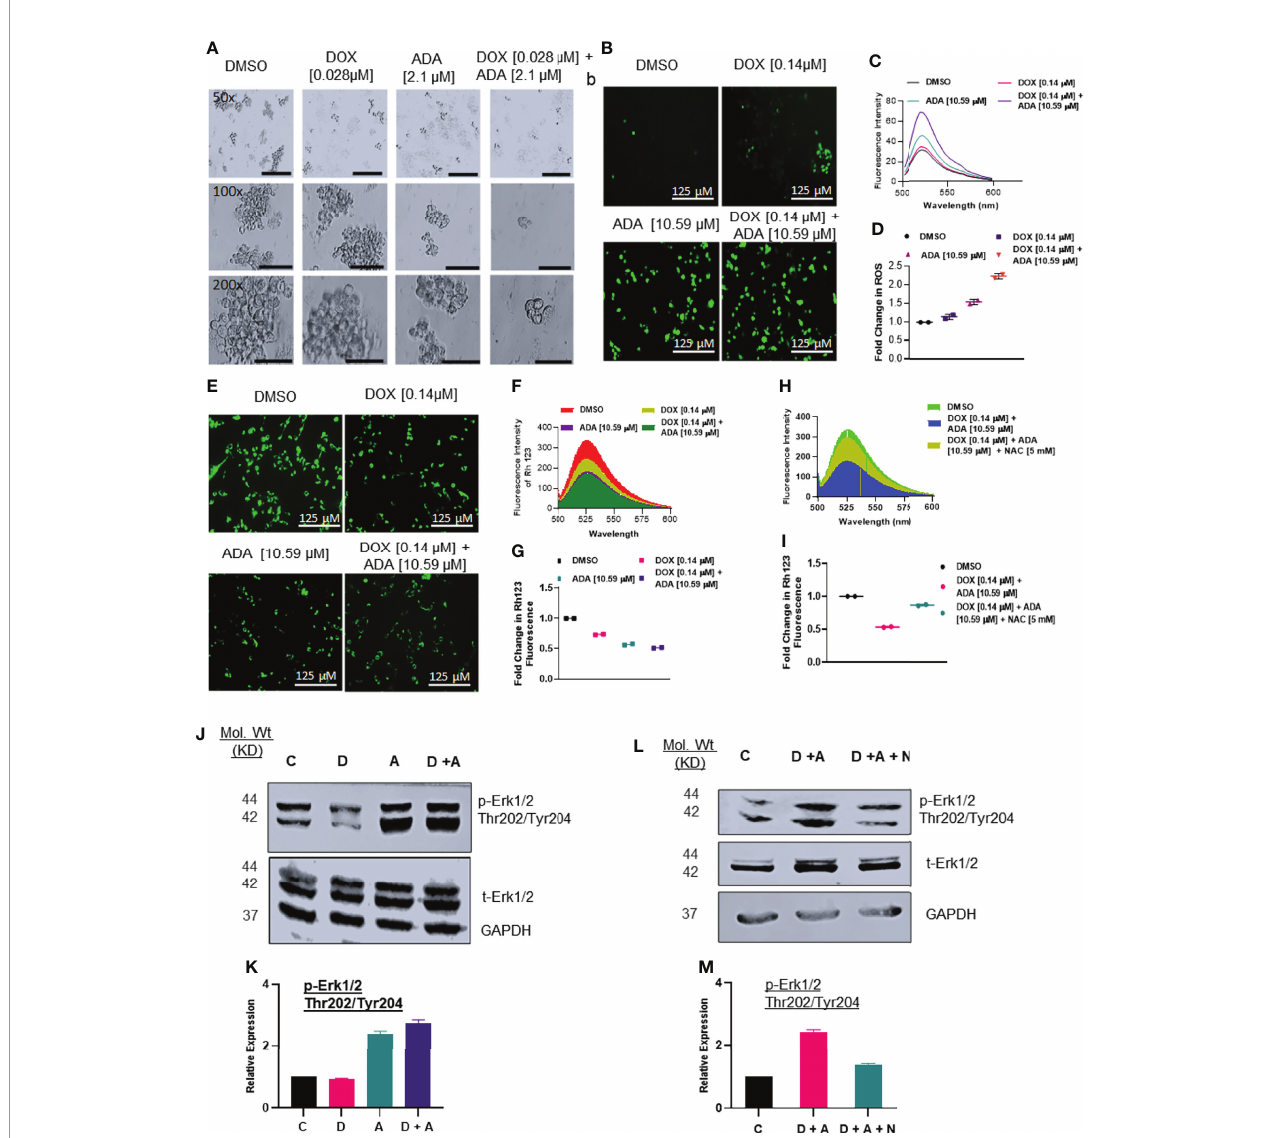
FIGURE 5 | Doxorubicin and adapalene affect the anchorage-independent growth of MDA-MB-231 cells and enhance apoptosis. (A) Representative images of the spheroid assay. Treatment with the combination of DOX and ADA signi fi cantly reduced the growth of TNBC cells in ultra-low attachment plates and reduced mammosphere size (Bar: 500 m m (50X), 200 m m (100X and 200X). (B) DCF-DA staining, (C) fl uorescence intensity & (D) fold change in ROS levels in MDA-MB-231 cells treated with ADA or DOX alone or in combination. (E) Rhodamine 123 staining, (F) fl uorescence intensity & (G) fold change in Rh123 staining levels in MDA- MB-231 cells treated with ADA or DOX alone or in combination both showing decrease in mitochondrial membrane potential upon treatment. (H) Fluorescence intensity & (I) fold change in Rh123 upon treatment with DOX-ADA and DOX-ADA + NAC [5µM]. (J, K) Western blots of p-Erk1/2 (Thr202/Tyr204) on MDA-MB-231 with DOX/ADA or the combination of both. (L, M) Western blots of p-Erk1/2 (Thr202/Tyr204) on MDA-MB-231 with DOX-ADA or DOX-ADA + NAC [5µM]. Data are representative of at least two independent experiments. C, control; D, doxorubicin; A, adapalene; A + D, adapalene + doxorubicin; A + D + N, adapalene + doxorubicin + NAC